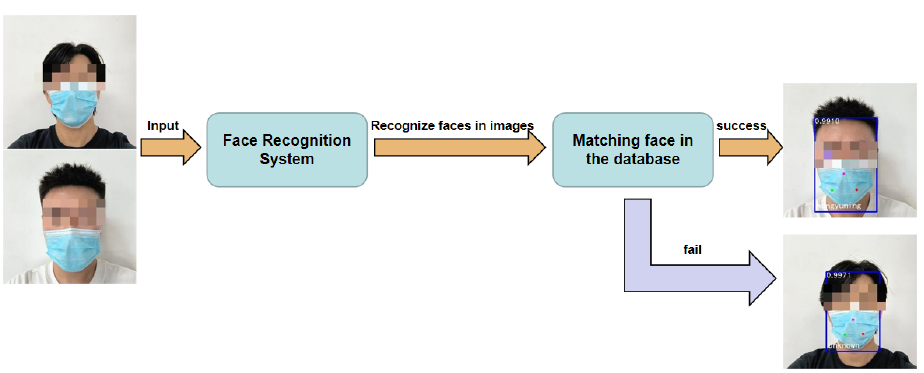
Figure 8. Results of identification between strangers and registered